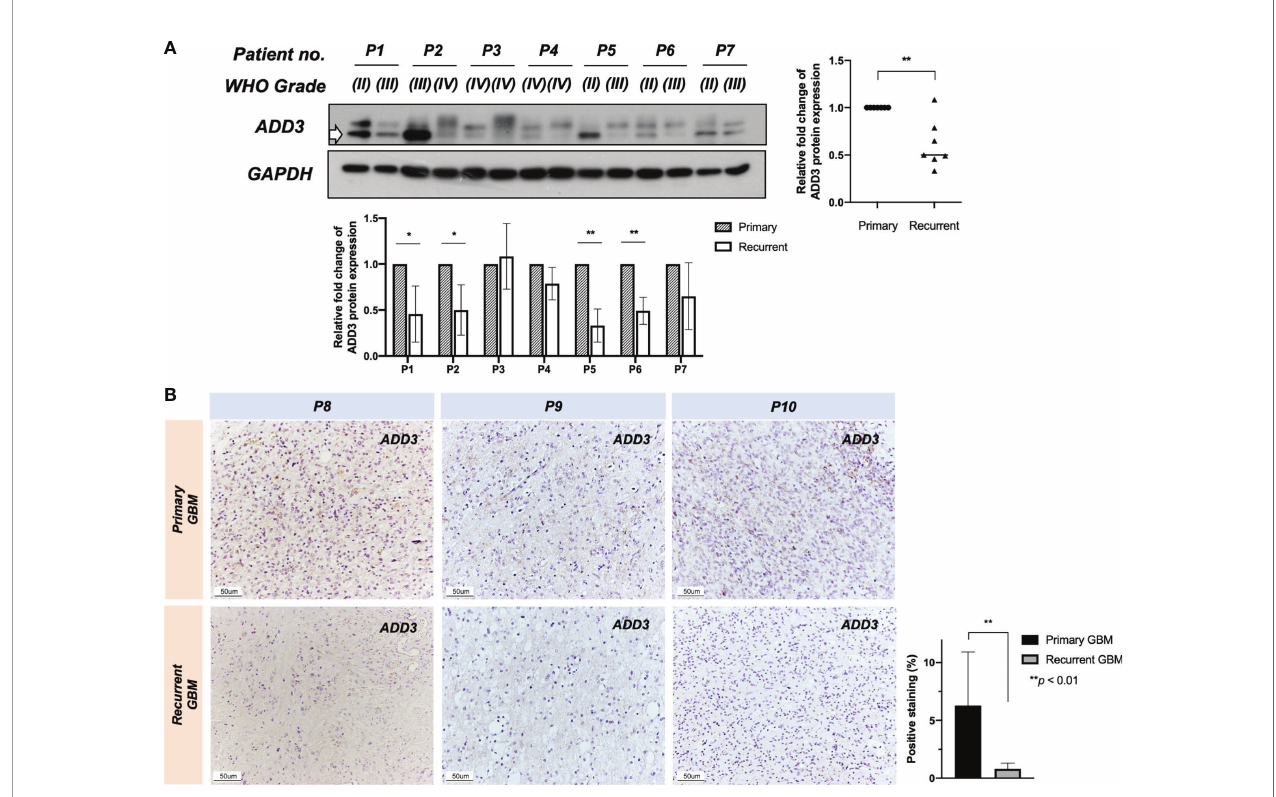
FIGURE 3 | Further loss of ADD3 expression during tumor progression. ADD3 expression was determined in 10 patient-paired primary – recurrent gliomas (P1 – P10) with different malignancy grades (WHO grade). (A) Western blotting analysis on seven (P1 – P7) recurrent pairs and quanti fi ed signal intensity of ADD3 protein bands (bottom band) normalized by GAPDH expression (bottom chart). Six out of seven recurrent gliomas had a further loss of ADD3 expression as compared with its primary tumor (graph on the right). (B) Representative immunohistochemical (IHC) staining of ADD3 in three primary – recurrent glioblastomas (GBMs) (P8 – P10) formalin- fi xed paraf fi n-embedded (FFPE) specimens, quanti fi ed with staining intensity in three individual tissue specimens for each of the tumors. Original magni fi cation ×200 (scale bar 50 ± m m). Data represent the mean ± SD from triplicates (* p < 0.05, ** p <